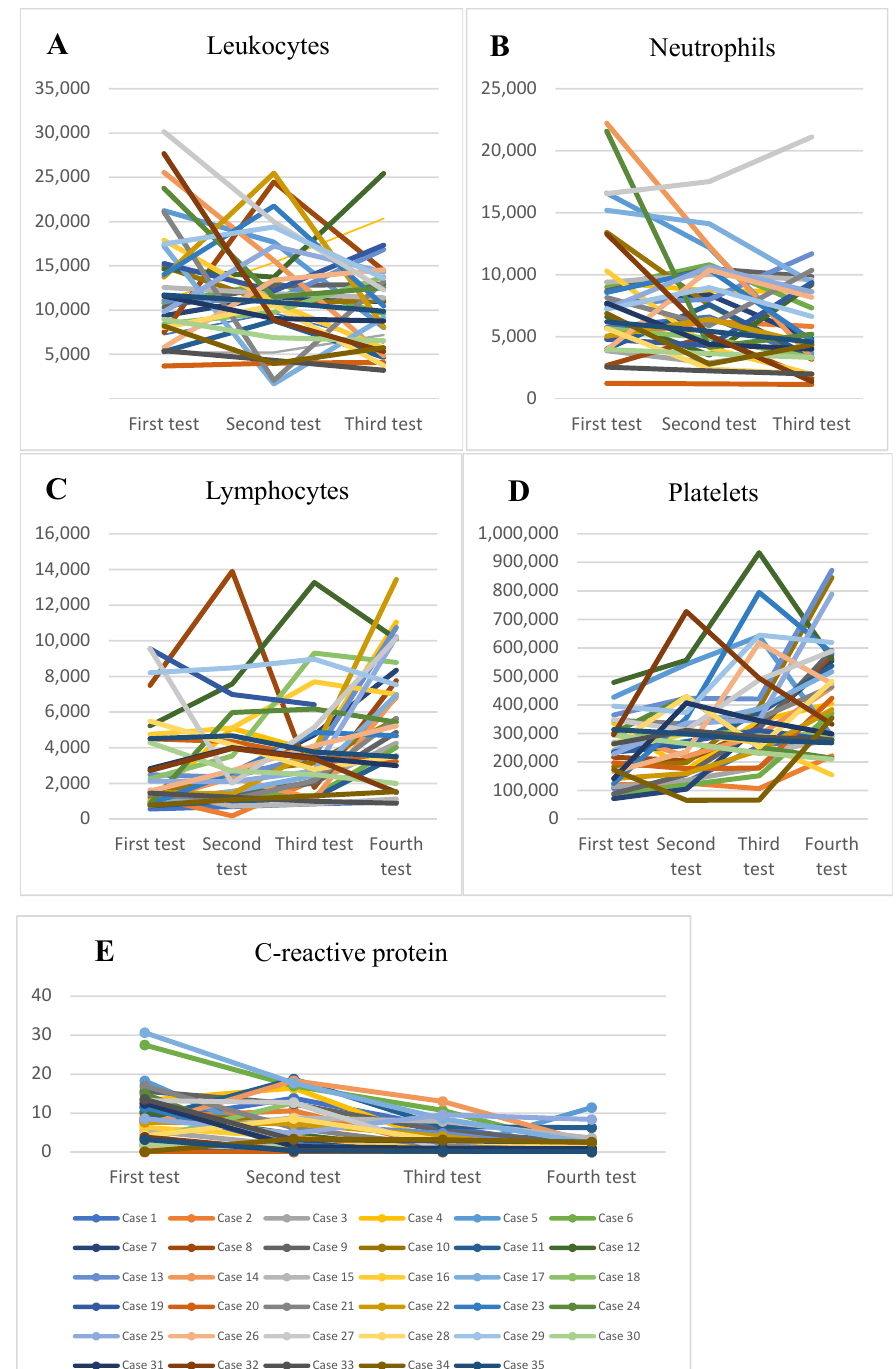
Figure 1. ( A ). The trendline of the values of leukocytes. ( B ). The trendline of the values of neutrophils. ( C ). The trendline of the values of lymphocytes. ( D ). The trendline of the values of platelets. ( E ). The trendline of the values of C-reactive protein.